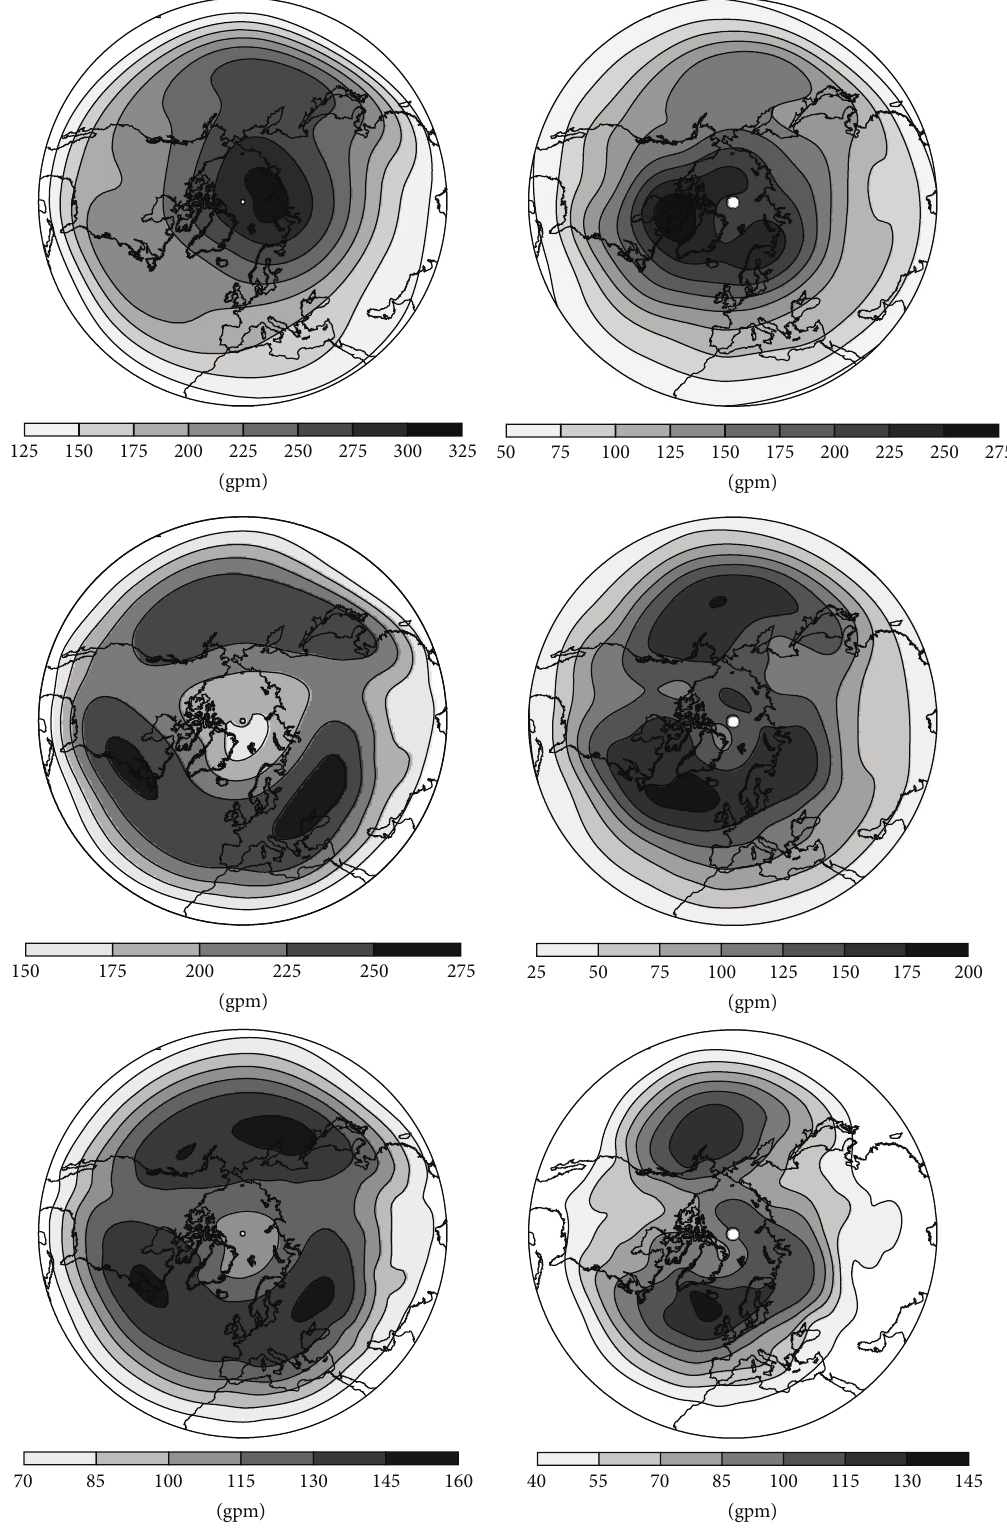
Figure 5: (Left) geopotential height standard deviation (gpm) of the (top) 167 hPa, (middle) 500 hPa, and (bottom) 833 hPa model level. (Right) same as left column, but for the layer-averaged NCEP-NCAR reanalysis